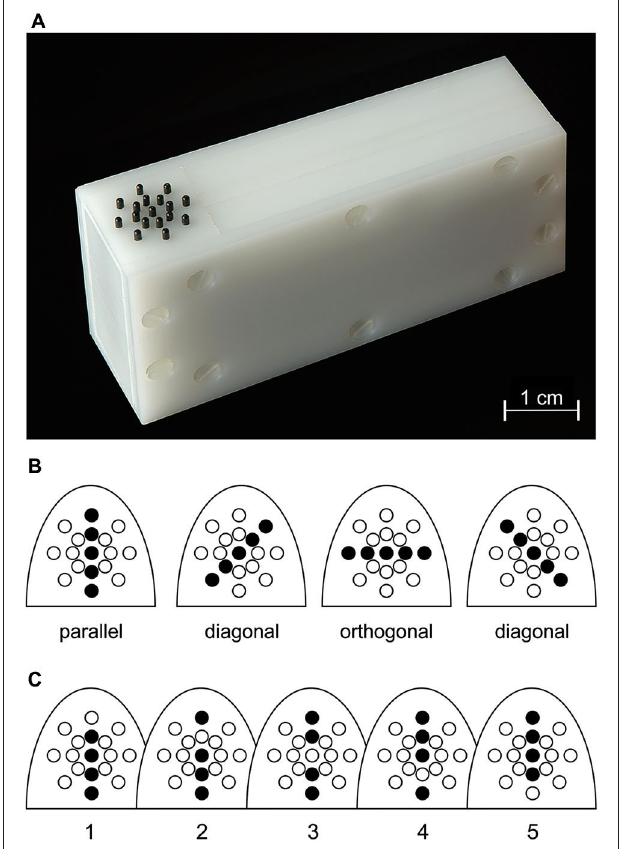
FIGURE 1 | Stimulation. (A) Tactile stimulator, with the 17 radially-arranged black pins visible on the left. (B) Illustration of the four possible orientation patterns and their location relative to the proximal-to-distal fingertip axis. (C) Alternativ pin patterns used for a given orientation, exemplified here for the orientation parallel to the finger